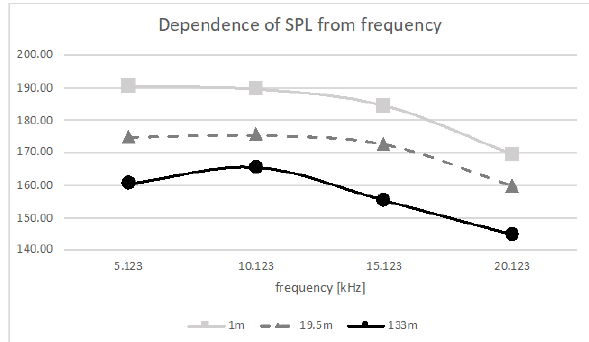
Fig. 7. Dependence of the average sound pressure level on the frequency at various distances between the speaker and the hydrophone.